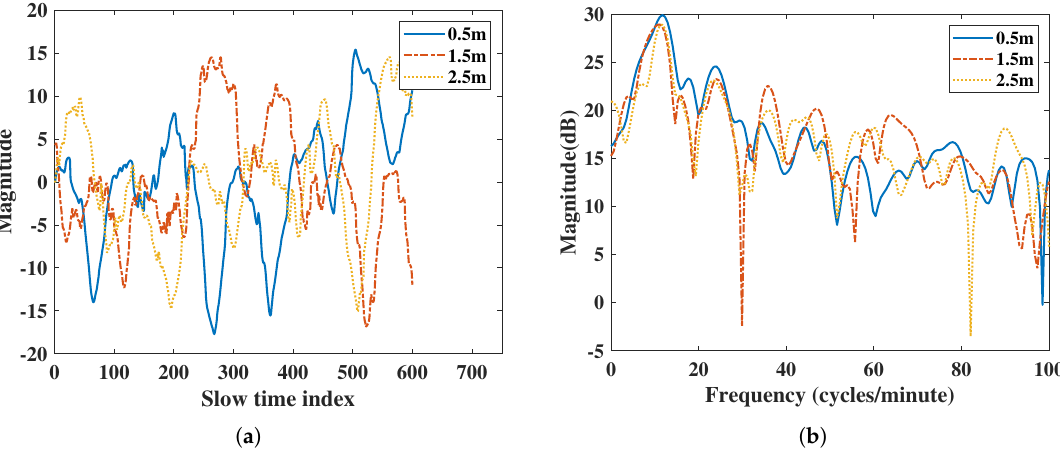
Figure 3. Vital signs extracted using FMCW radar at 0.5 m, 1.5 m, and 2.5 m: ( a ) vital signs extracted by FMCW radar in the time domain, ( b ) vital signs extracted by FMCW radar in the frequency